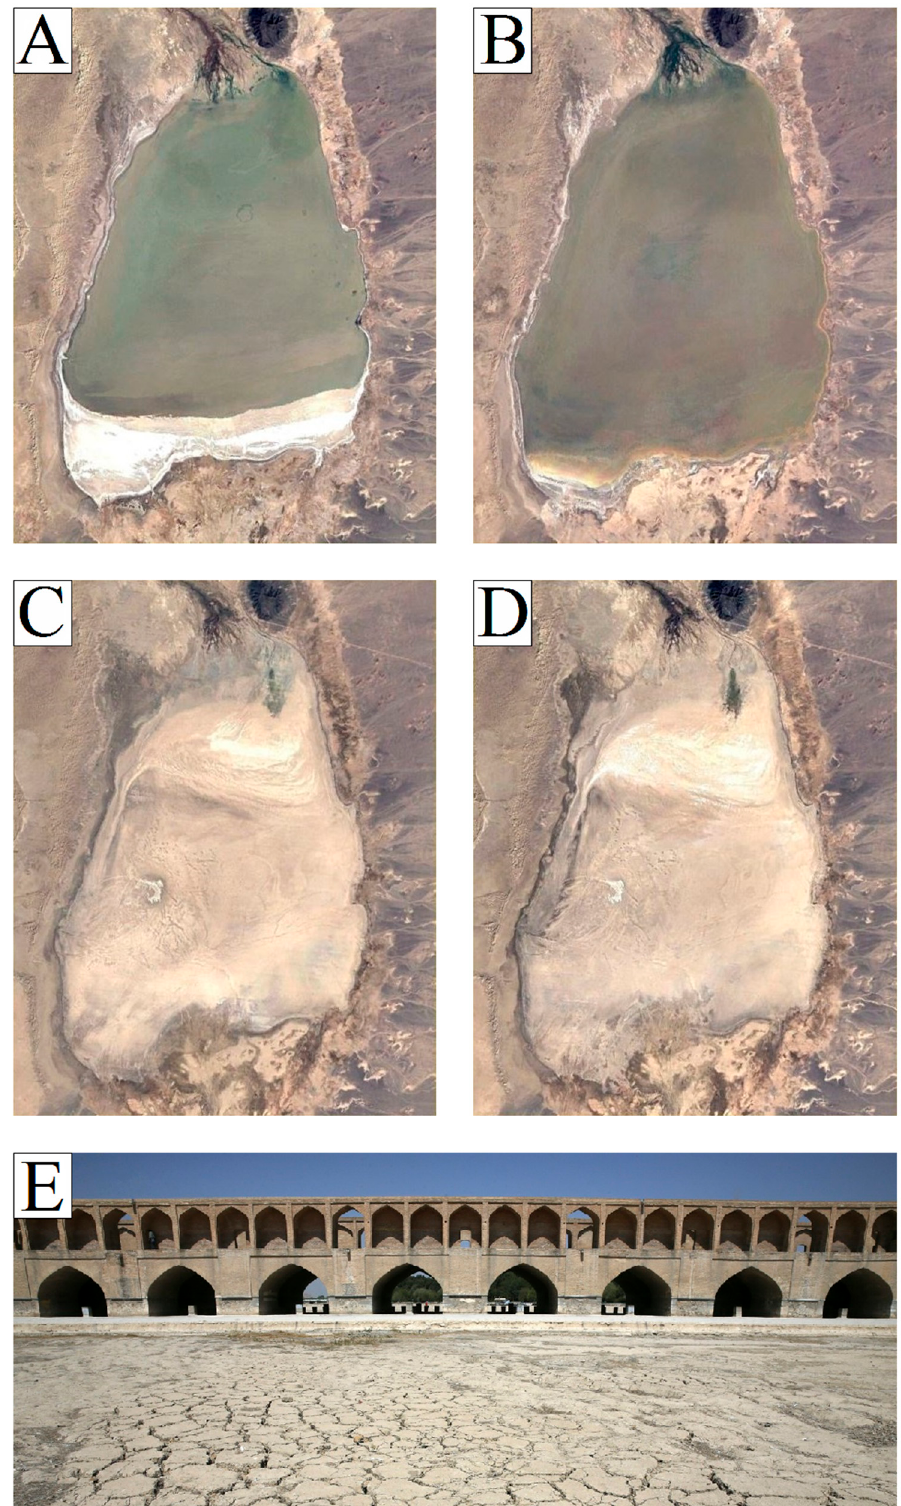
Figure 5. Satellite images showing the Gavkhuni Wetland during different years. ( A ): 1988 (high inflow), ( B ): 1993 (high inflow), ( C ): 2008 (low inflow) and ( D ): 2010 (low inflow) (Source Google Earth). ( E ): the Zayanderud River totally dry under the historical Allahverdi Khan Bridge in Isfahan (Source: AP Photography—Vahid Salemi 2018).